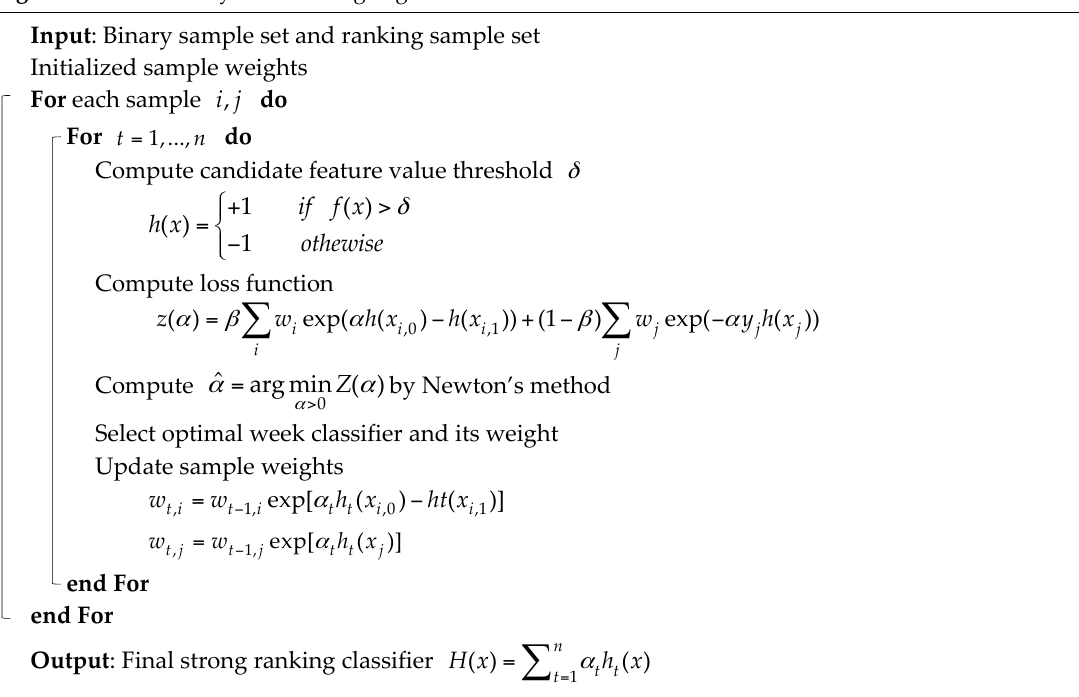
Algorithm 1: Online Hybrid Boosting Algorithm